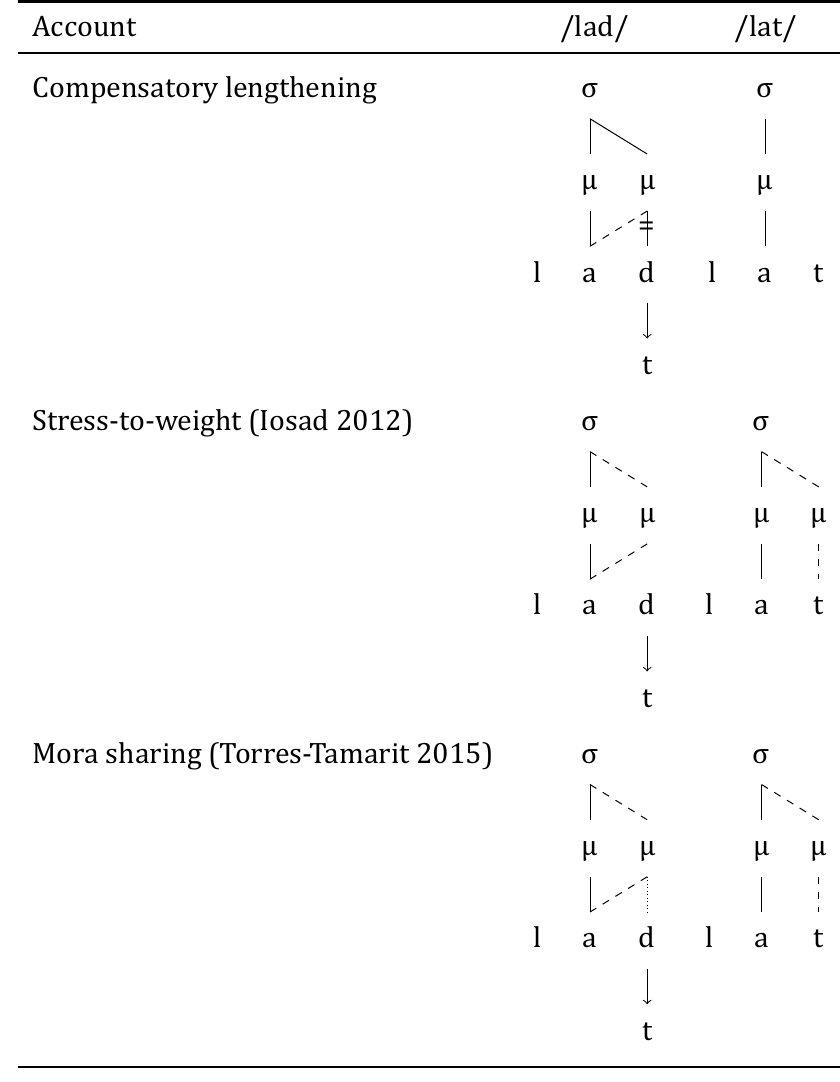
Table 1: Derivations of vowel